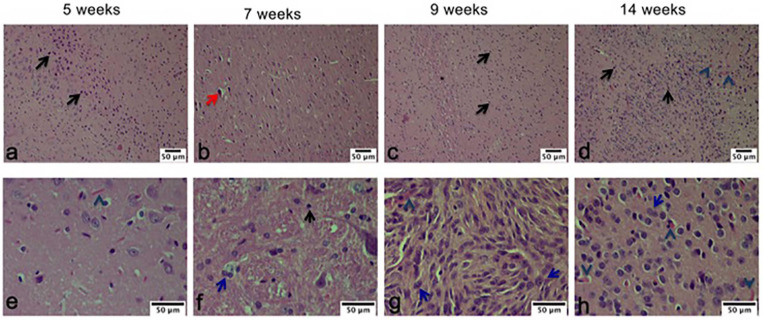
Hematoxylin and eosin (H&E) staining analysis of glioma tissue. The images are representative of three animals per treatment. Hyperbasophilic cells (black arrow), Hyperchromatics cells (red arrow), vessel proliferation (arrowhead), mitosis (blue arrow). Scale bars = 50 μm.